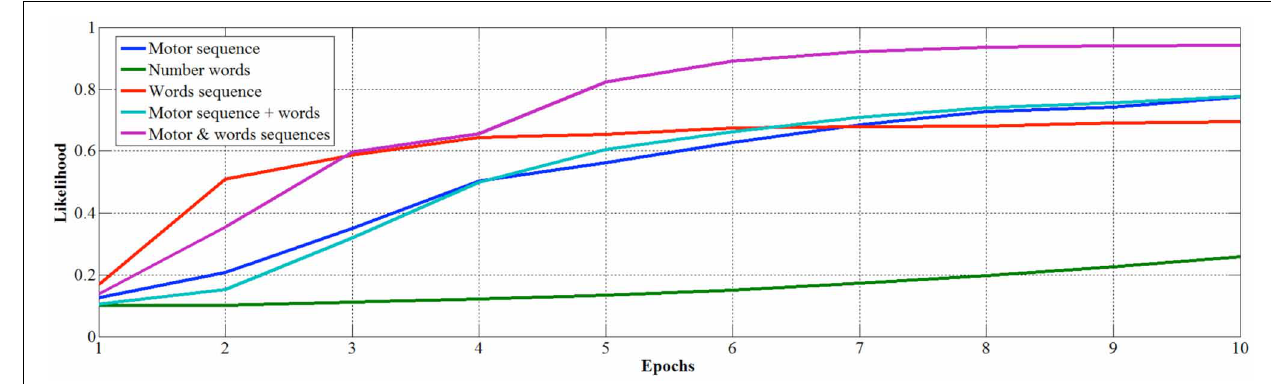
FIGURE 6 | Average likelihood with number classes with varying epochs.